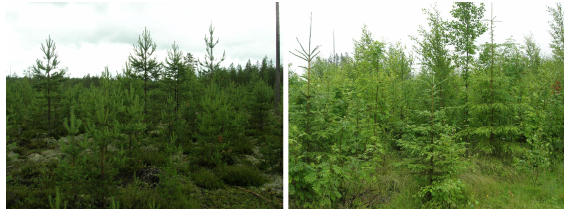
Figure 1. Examples of the selected stands. A 12-year-old sowed pine stand on a barren site (left), and a 11-yr-old planted spruce with a naturally regenerated broadleaved mixture on a fertile site (right).